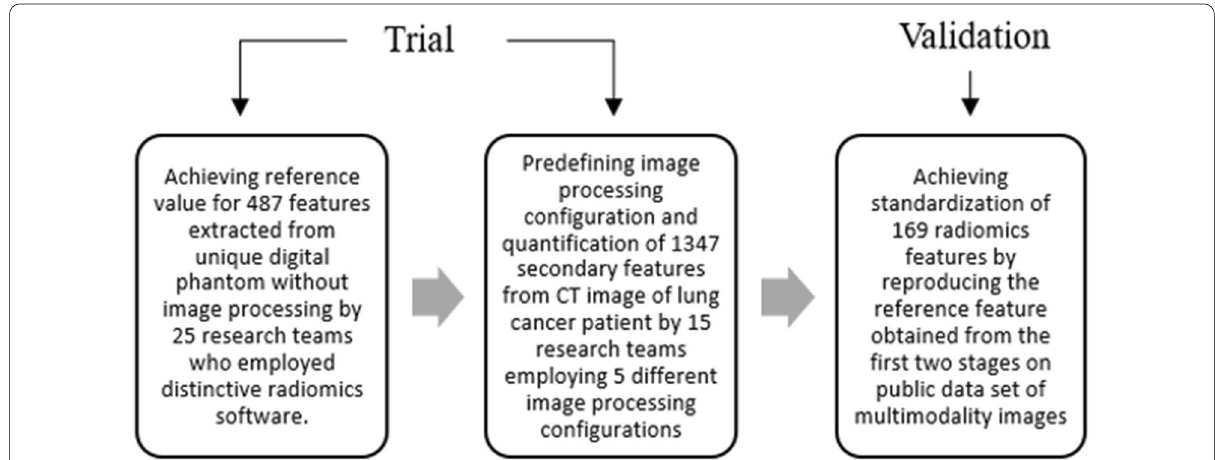
Fig. 10 Flowchart of validation study by Zwanenburg, Alex et al., overview